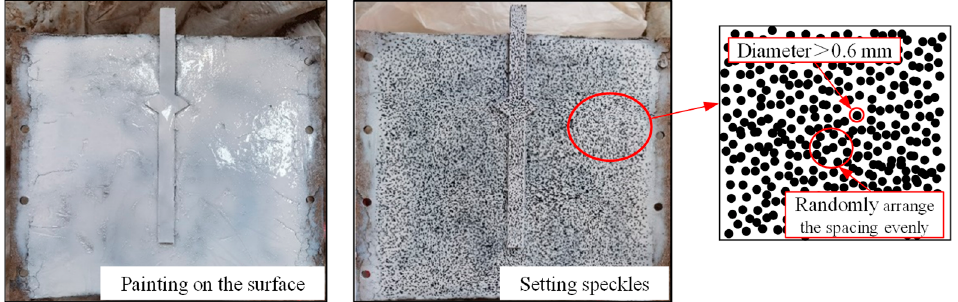
Figure 5. Collection of surface painting photos.